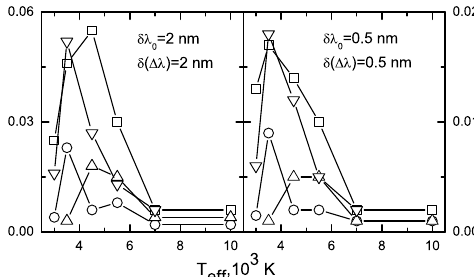
Fig. 1. Accuracy of the magnitude F390 versus effective temperature. Trans- formation to the standard system were based on the following stars: all stars (squares); dwarfs (circles); giants (trian- gles up); supergiants (triangles down). δλ 0 and δ (Δ λ ) are 2 nm (left panel) and 0.5 nm (right